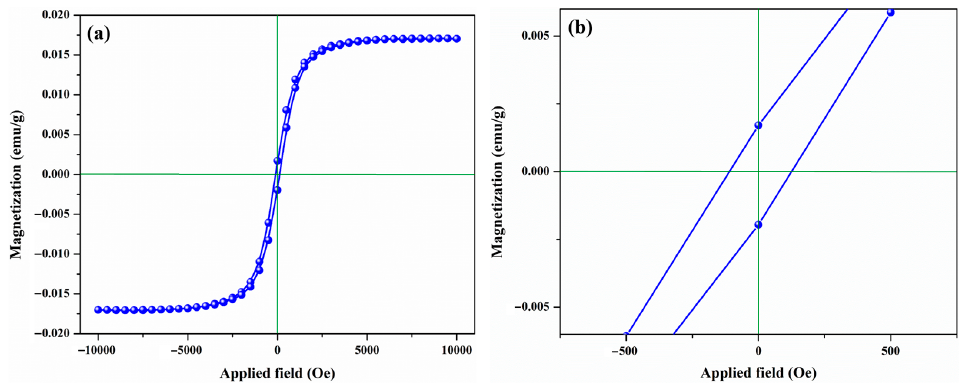
Figure 7. Magnetic hysteresis curve of Co-doped ZnO/CdS nanosheets. Table 2. Coercivity, saturation magnetization and retentivity of Co-doped ZnO/CdS nanosheets. Parameter